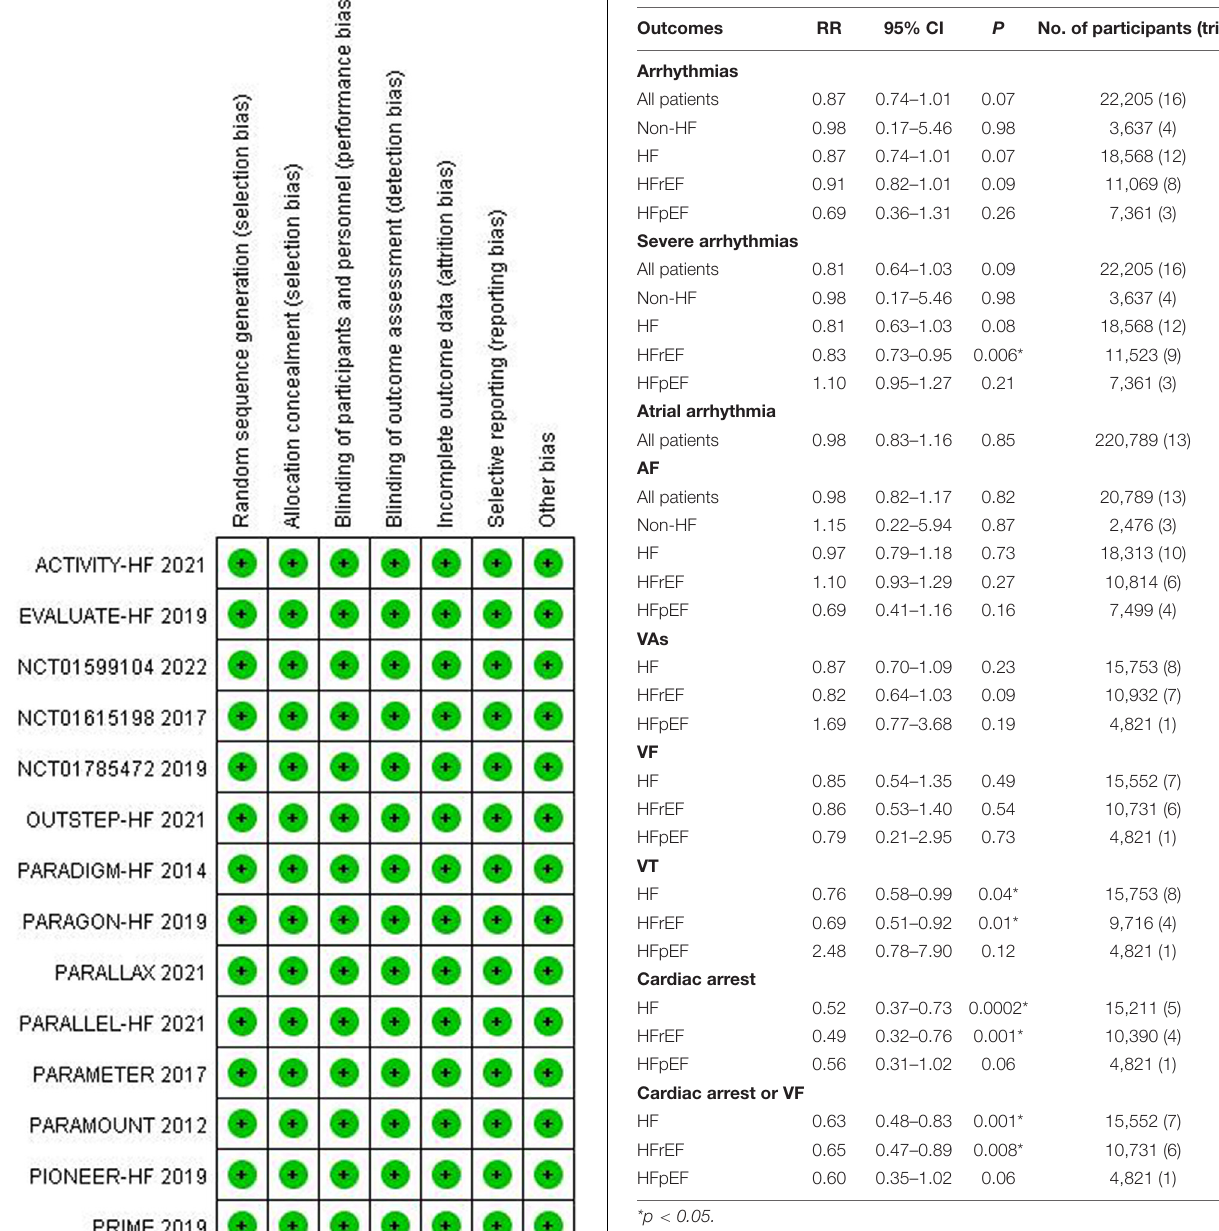
TABLE 2 | Results of